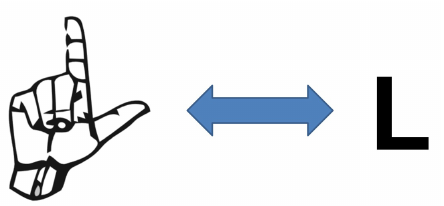
Figure 2. Bijective function mapping from gestures to